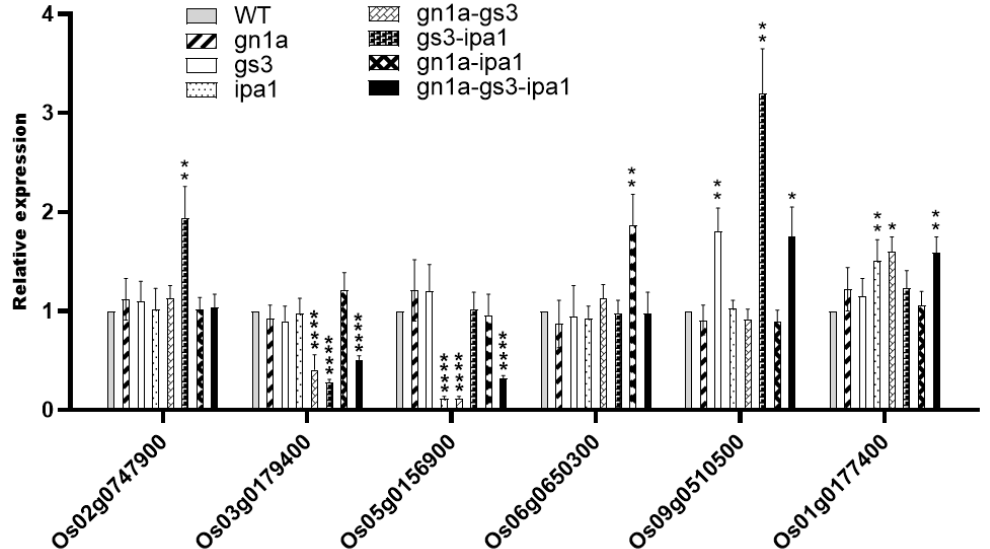
Figure 5. Expression of grain weight, quality, and plant height-related genes in young panicle from WT, gn1a , gs3 , ipa1 , gn1a-gs3 , gn1a-ipa1 , gs3-ipa1 , gn1a-gs3-ipa1. Date are shown as mean ± SD from three replicates; “*”, “**” and “****” indicated significant differences at p < 0.05, p < 0.01 and p < 0.001, respectively.